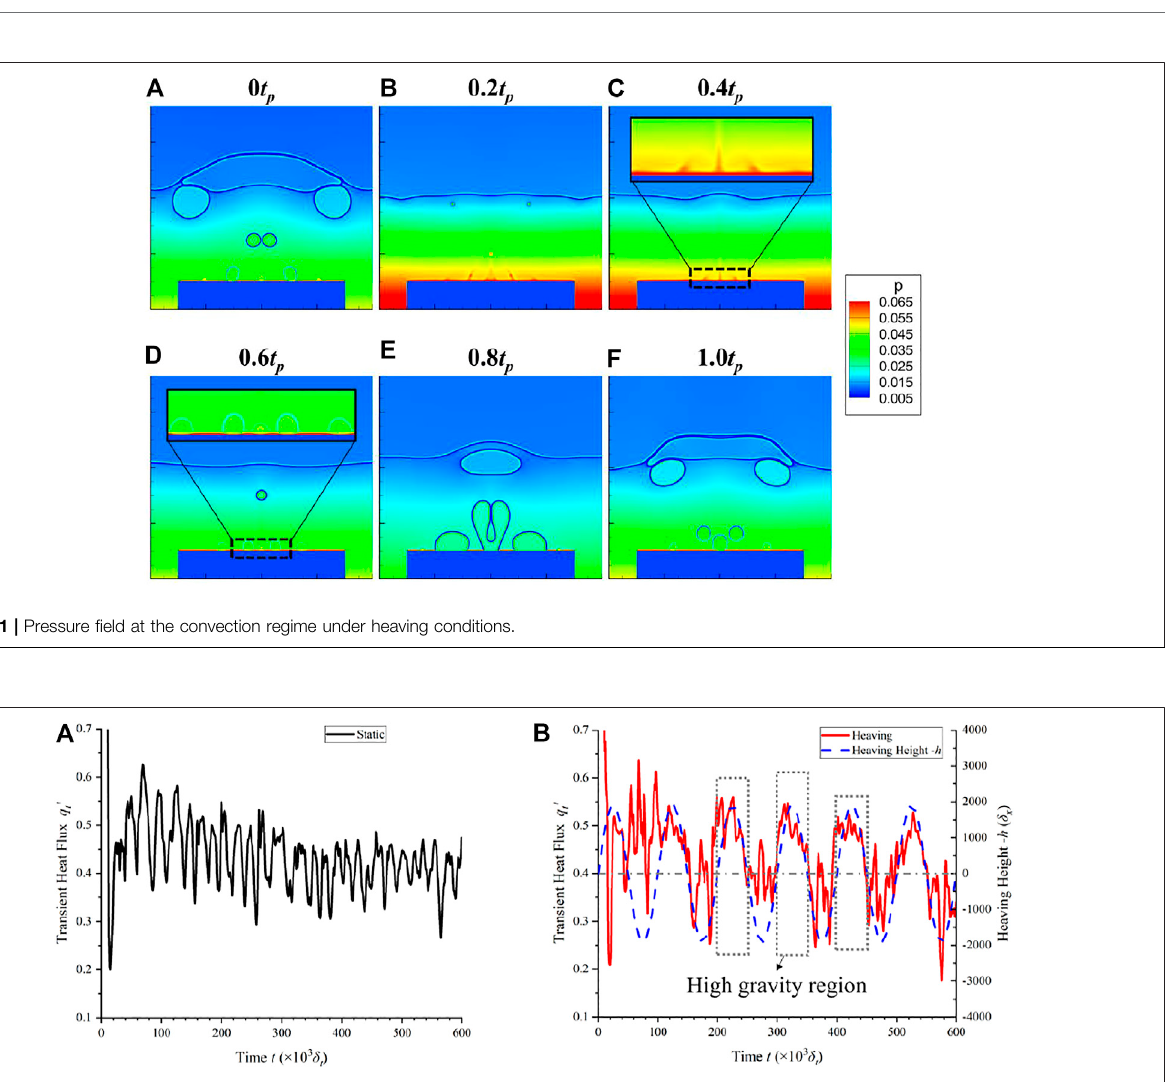
Frontiers in Energy Research |